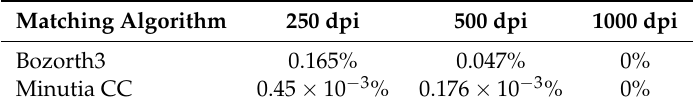
Table 4. Probability value of a successful attack FAR A for each resolution of the original image for the two matching